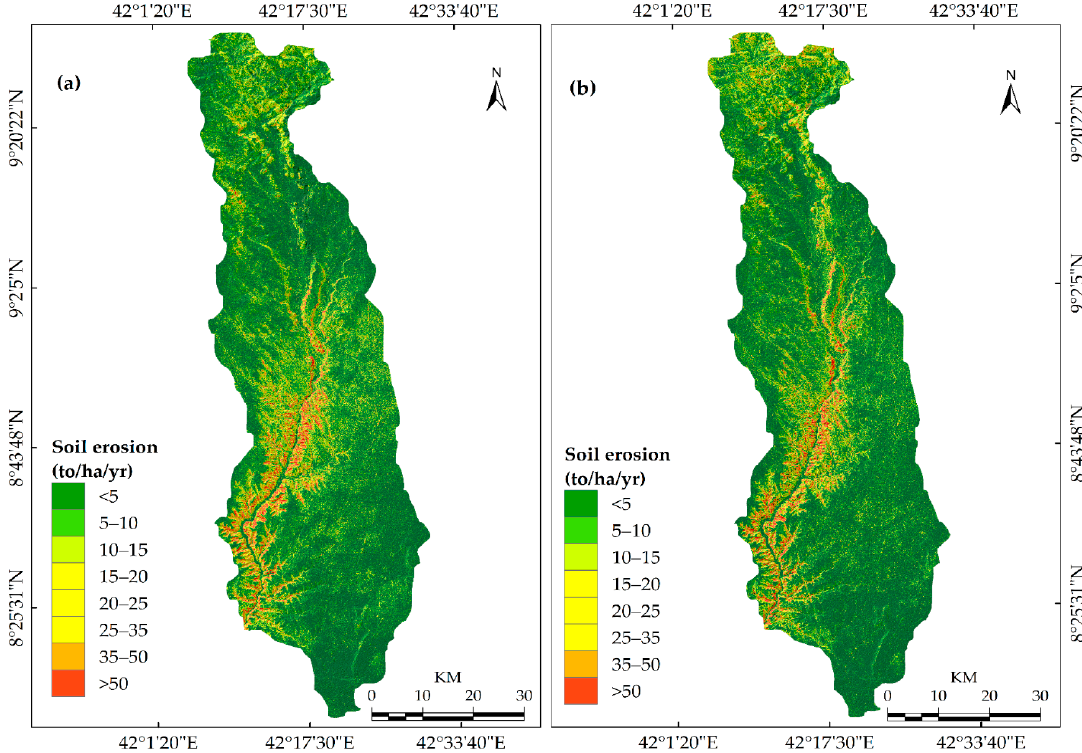
Figure 5. Soil erosion risk in the Erer Sub-Basin, North East Shebelle Basin, Ethiopia; ( a ) in 2000, ( b ) 2018. Table 7. Areas (km 2 ), percentages, and changes in soil erosion risk classes between 2000 and 2018. Erosion Risk